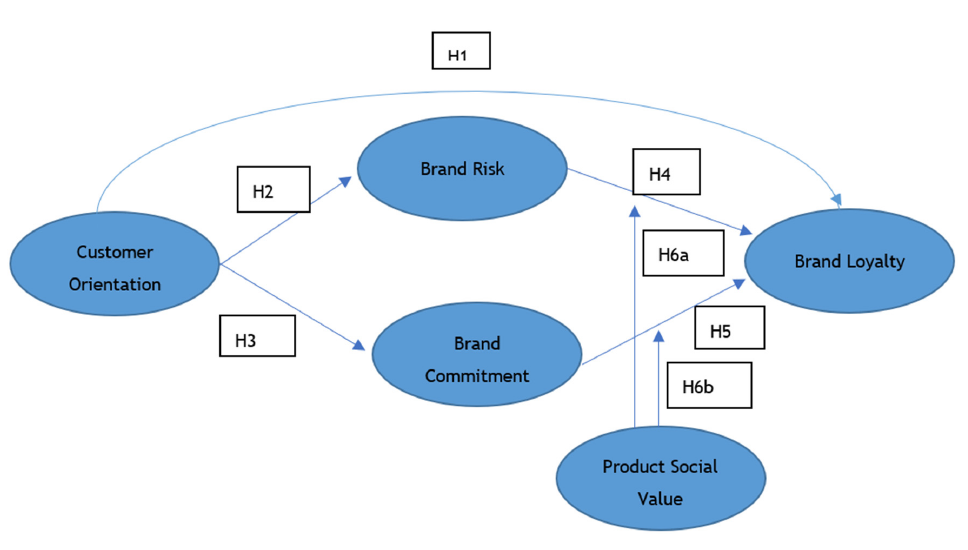
Figure 1. Research Model.